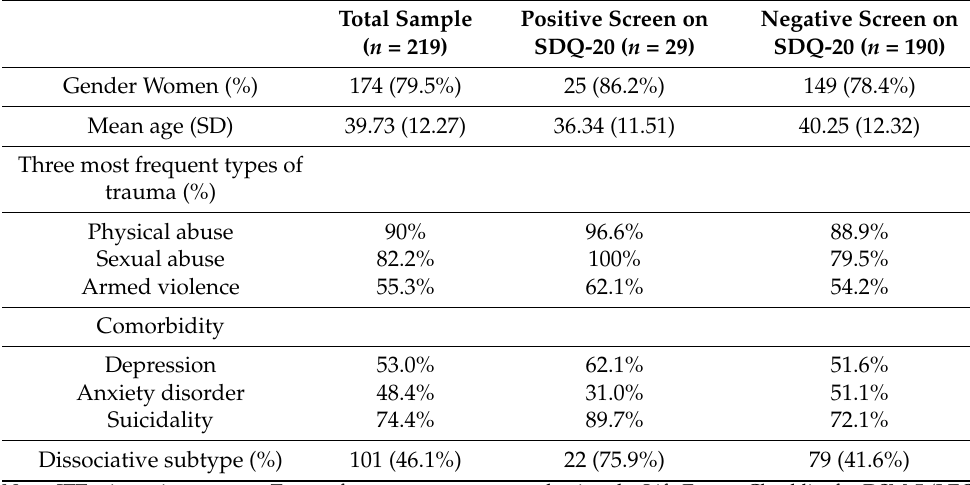
Table 1. Baseline characteristics of the ITT sample used for main analysis.